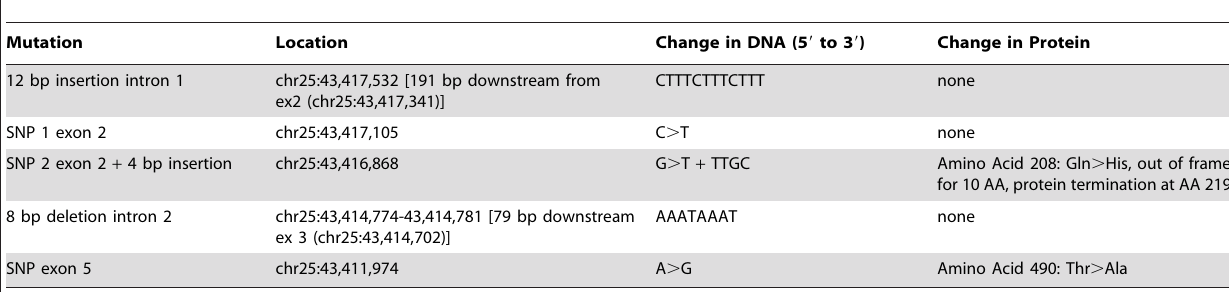
Table 4. Sequencing results of SLC19A3 in dogs with